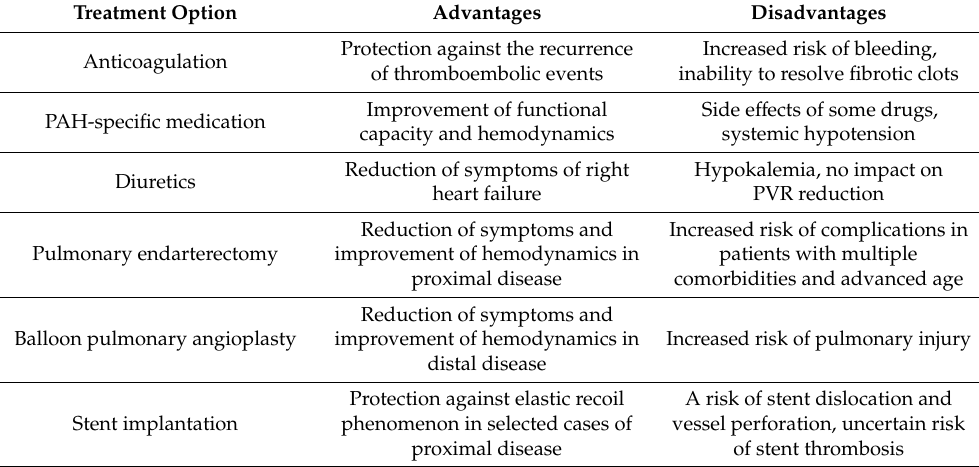
Table 2. Treatment options for chronic thromboembolic pulmonary hypertension